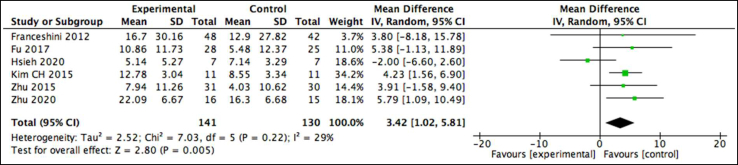
Pooled analysis for the Fugl-Meyer Assessment in patients with stroke.